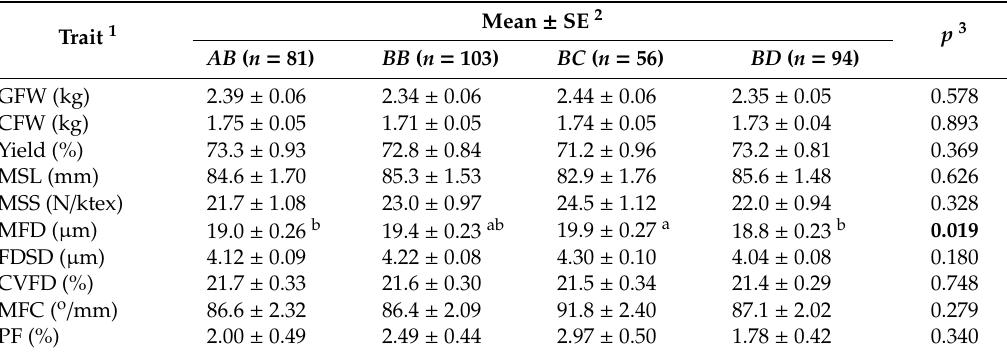
Table 2. Association of the KRTAP28-1 genotype and wool